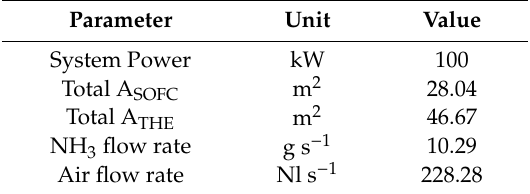
Table 13. Absolute parameters values for a 100 kW system.